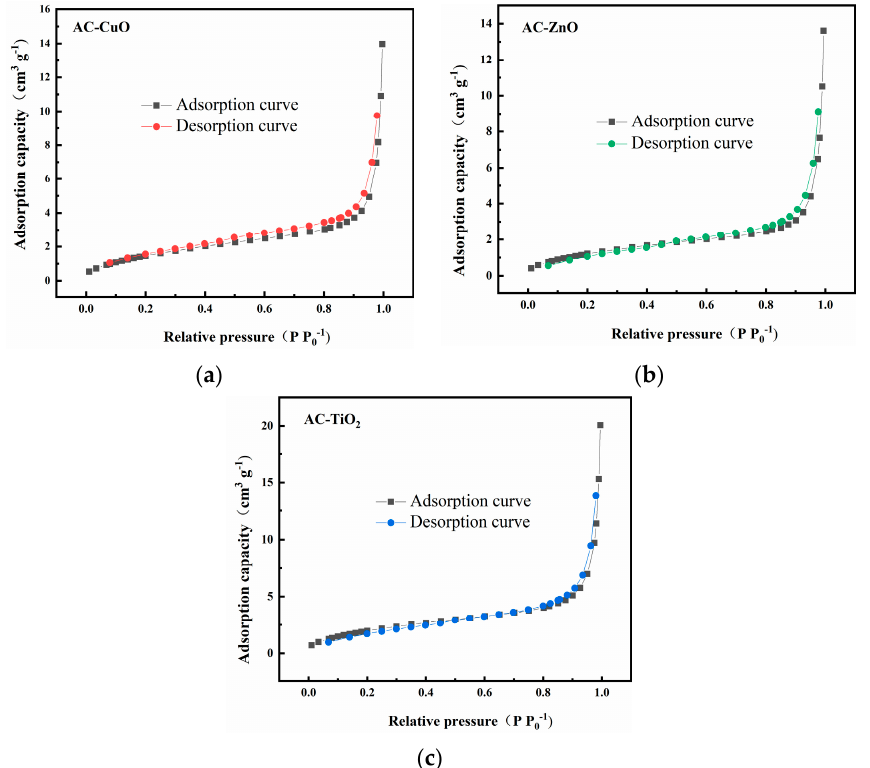
Figure 4. N 2 adsorption-desorption curves of ( a ) AC-CuO; ( b ) AC-ZnO; and ( c ) AC-TiO 2 .